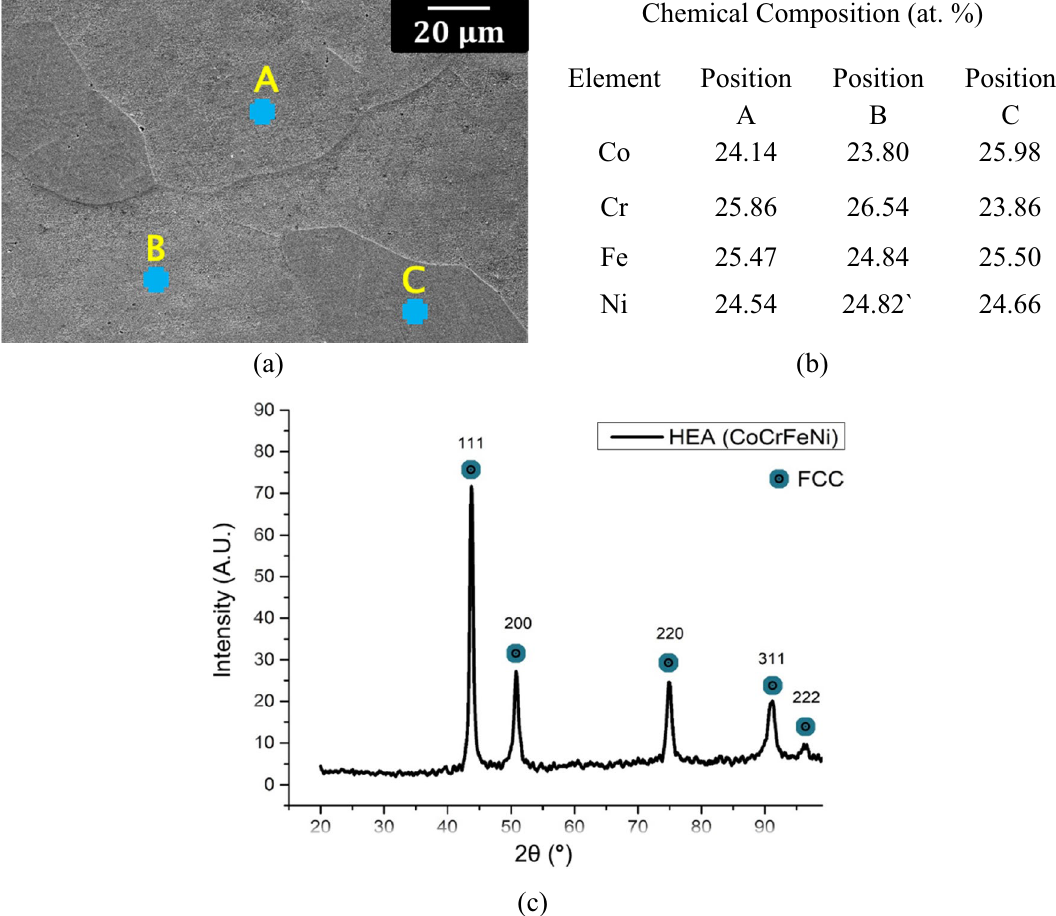
Figure 1. Characterization of the base CoCrFeNi HEA: ( a ) SEM micrograph, ( b ) EDS analysis of the three regions labelled in ( a ), and ( c ) XRD pattern showing the single fcc phase composition.